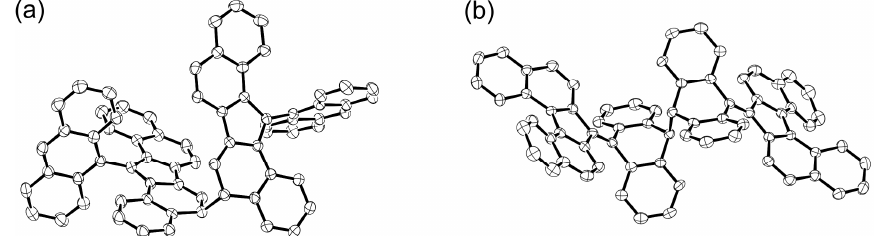
Figure 8. σ -Dimer structures of ( a ) 8 and ( b ) 10 determined by X-ray crystallographic analysis.